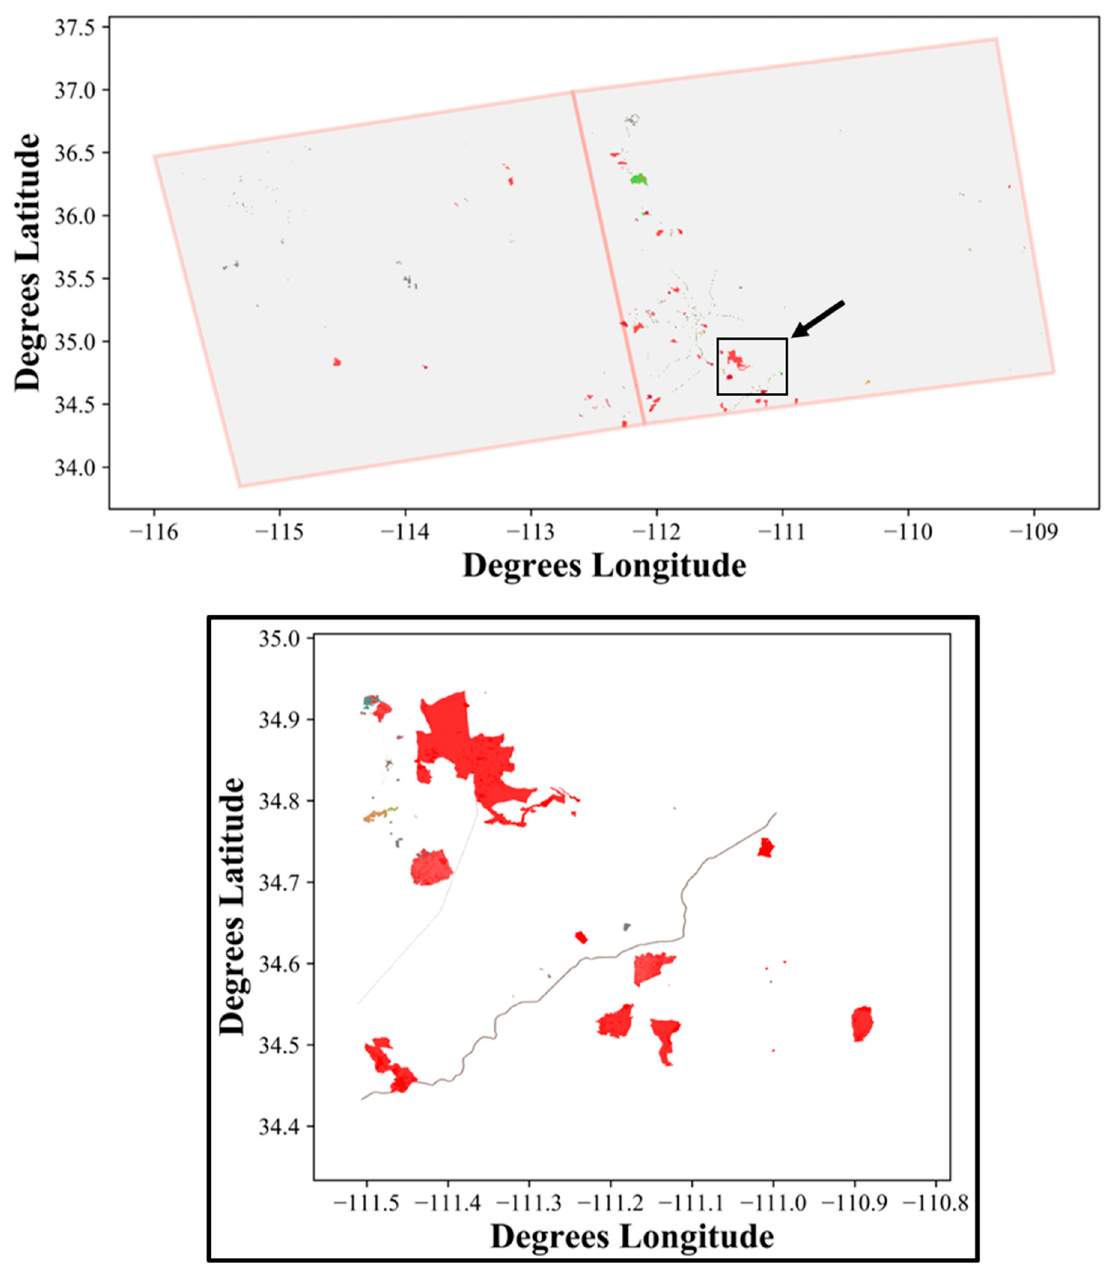
Figure 4. Map of 2015 disturbances overlain the Grand Canyon (red outline) prototype area (top image), where the black arrow highlights the location of the inset map (bottom image). Disturbances shown include fire (red), clear cut areas (light brown), herbicide treatments along roads (dark brown), biological treatments (gray), and prescribed fire (blue).